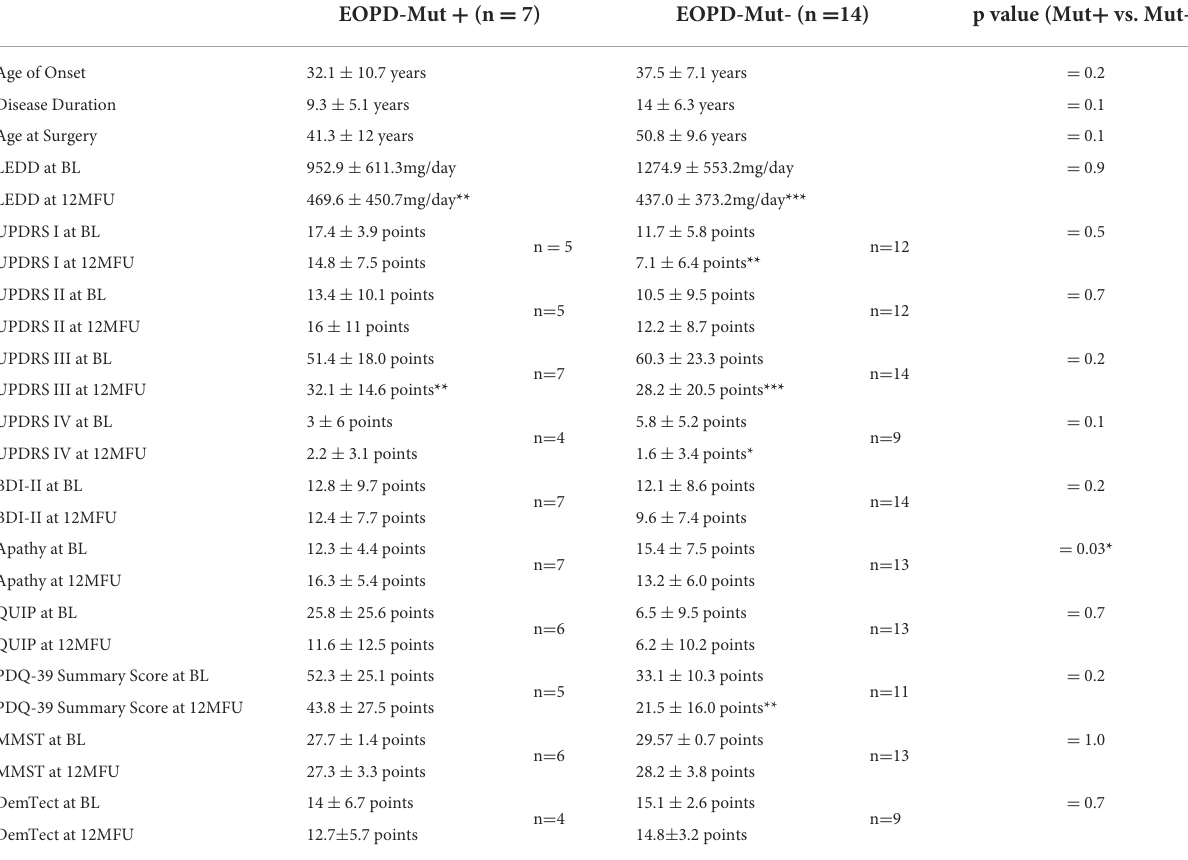
TABLE 2 Subcohort analysis of Early-Onset-Parkinson’s patients with (Mut + ) and without (Mut-) PD-gene mutation with regard to demographic differences, e.g. age of onset, disease duration and age at surgery, as well as baseline (BL) as well as 12-months follow-up (12-MFU) results of motor and non-motor symptoms including mood, apathy, impulsiveness and cognition and PDQ-39-summary index representing quality of life changes given in mean ± standard